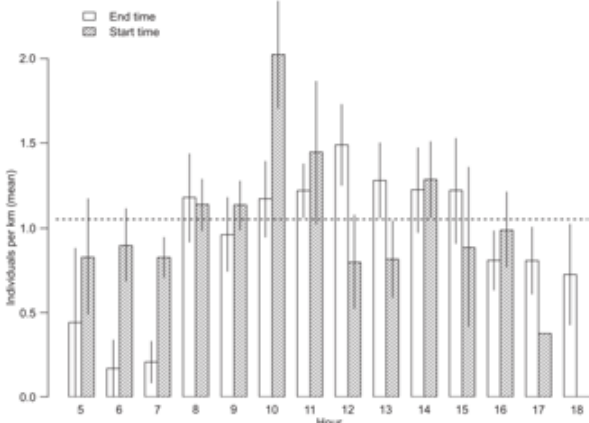
Figure 3. Abundance of P. unifilis by time of day. Mean (± 1 SE) abundances (individuals per kilometer) recorded by trip start (lined bars) and end times (open bars) during 333 river-based surveys around the Los Amigos Biological Station, Amazonian Peru, from April 2004 to August 2008. The dashed horizontal line is the aver- age abundance recoded from all